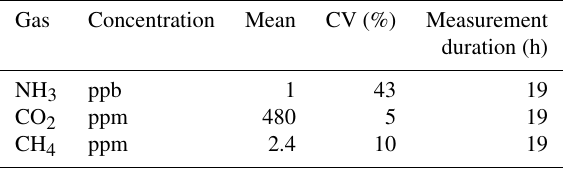
Table A1. Measured concentrations of NH 3 , CO 2 and CH 4 in lab- oratory zero air (CV denotes coefficient of variation).